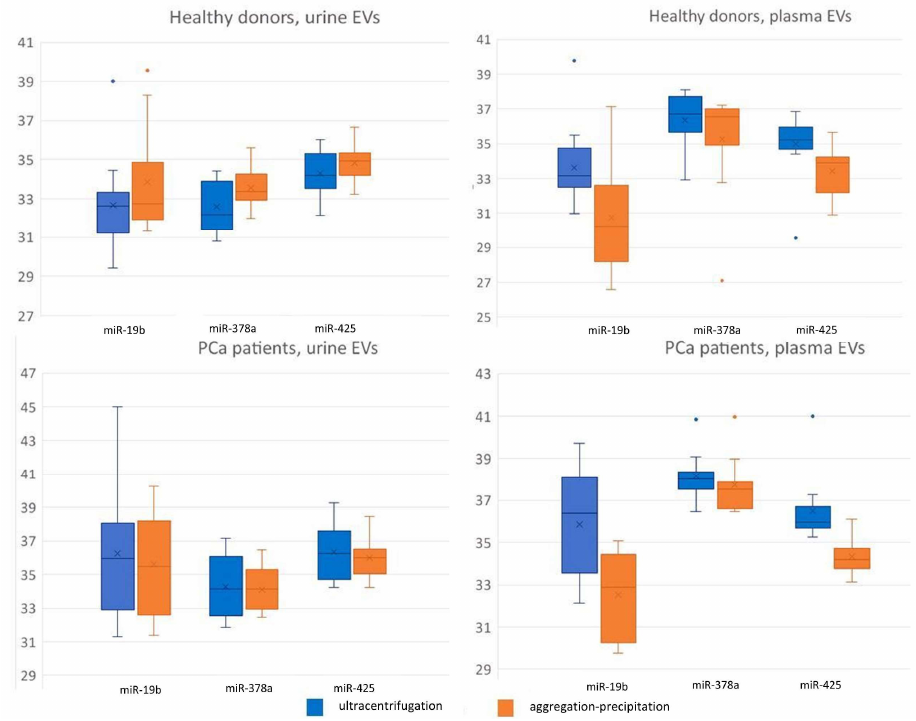
Figure 6. Mir-19b, miR-378, miR-425, and cel-miR-39 Cp values when isolated from the urine and plasma extracellular vesicles of healthy donors and PCa patients, five-fold diluted